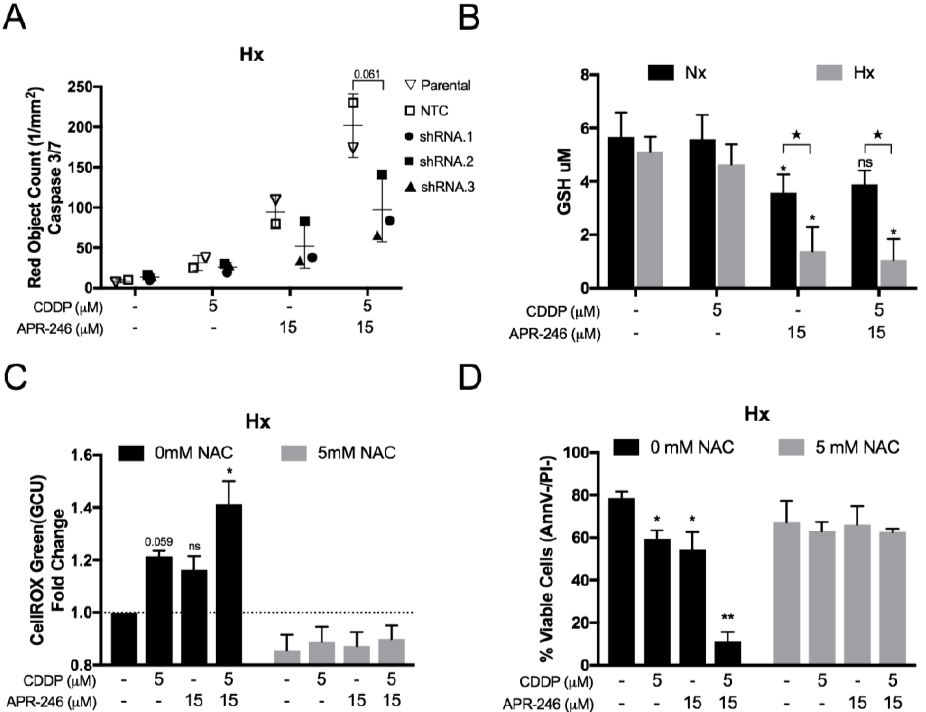
Figure 5. Role of p53 Q331 * and ROS in the synergistic combinatory effect of CDDP and APR-246 under hypoxia. ( A ) NCI-H2228 Q331 * parental cell line, non-template control (NTC), and three TP53 shRNA